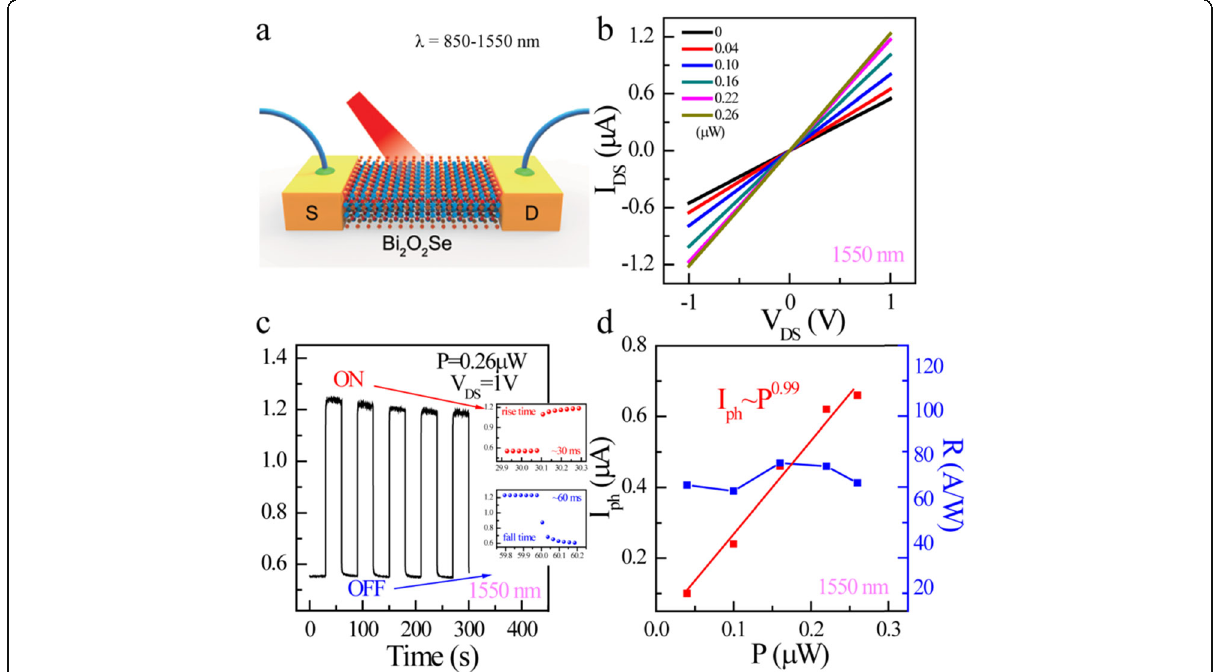
Fig. 2 Photoelectric response to telecommunication band (wavelength 1550 nm) of multilayer Bi 2 O 2 Se – based photodetector. a Schematic 3D view of Bi 2 O 2 Se-based photodetector under illumination. b I-V curves of Bi 2 O 2 Se-based photodetector under different light intensities. c Time- dependent photoresponse behaviors of Bi 2 O 2 Se device under 1550-nm light illumination ( P = 0.26 uW). The inset shows an ultrafast photo response of the device. d Photocurrent and photoresponsivity of Bi 2 O 2 Se-based photodetector under different light